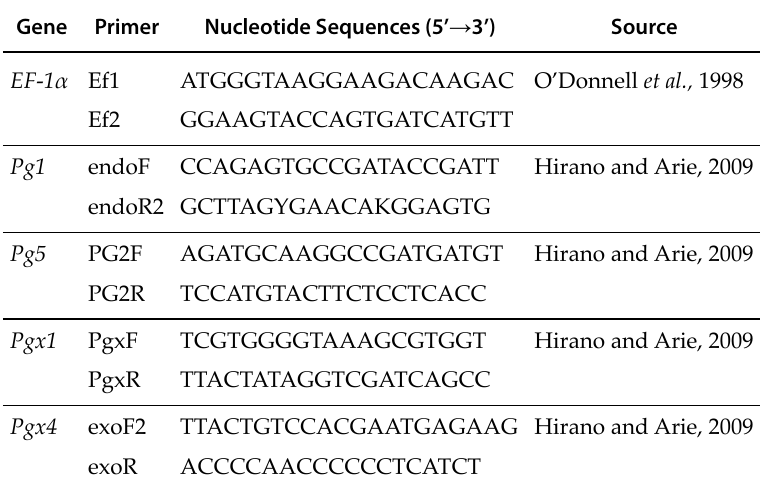
Table 2. Primers used to amplify polygalacturonase genes. Gene